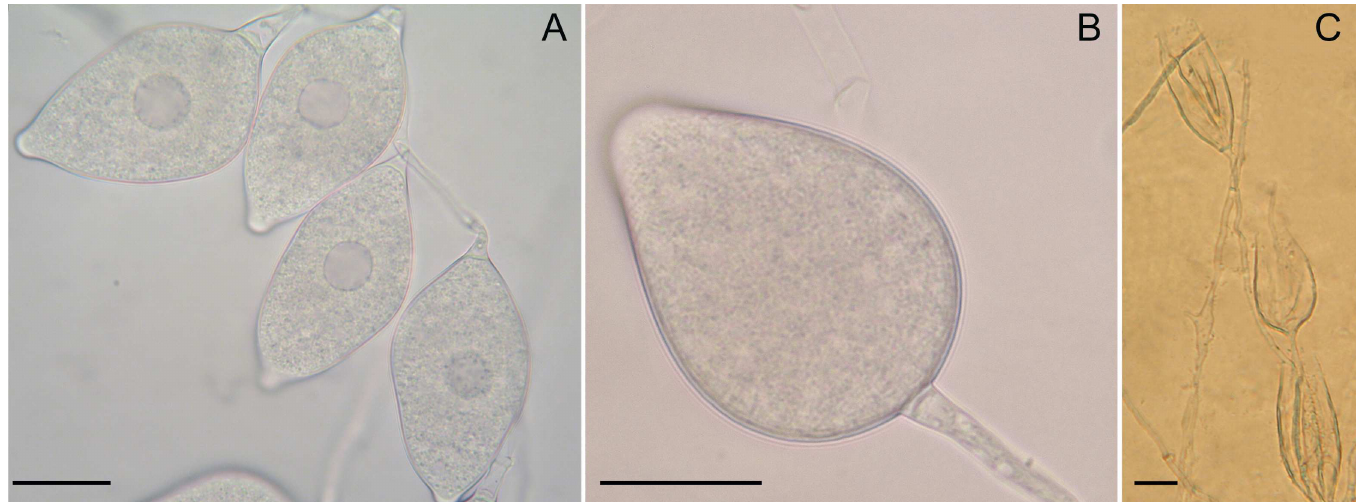
Fig 3. Morphology of vegetativestructuresof Phytophthora isolates. A. Cluster of fusiform, papillatesporangiaof P . sp. mekongensis. B. Obpyriform, persistent, nonpapillatesporangium of P . sp. prodigiosa.C. Internal and externalextendedproliferations of persistent sporangiaof P . sp. prodigiosaproduced in water. (Scale bar = 20 μ